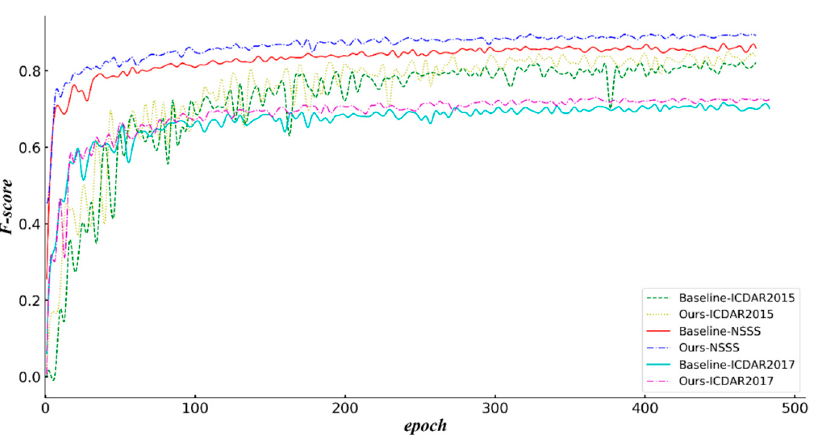
Figure 12. F-score curves of Baseline and our method on ICDAR2015, ICDAR2017-MLT, and NSSS